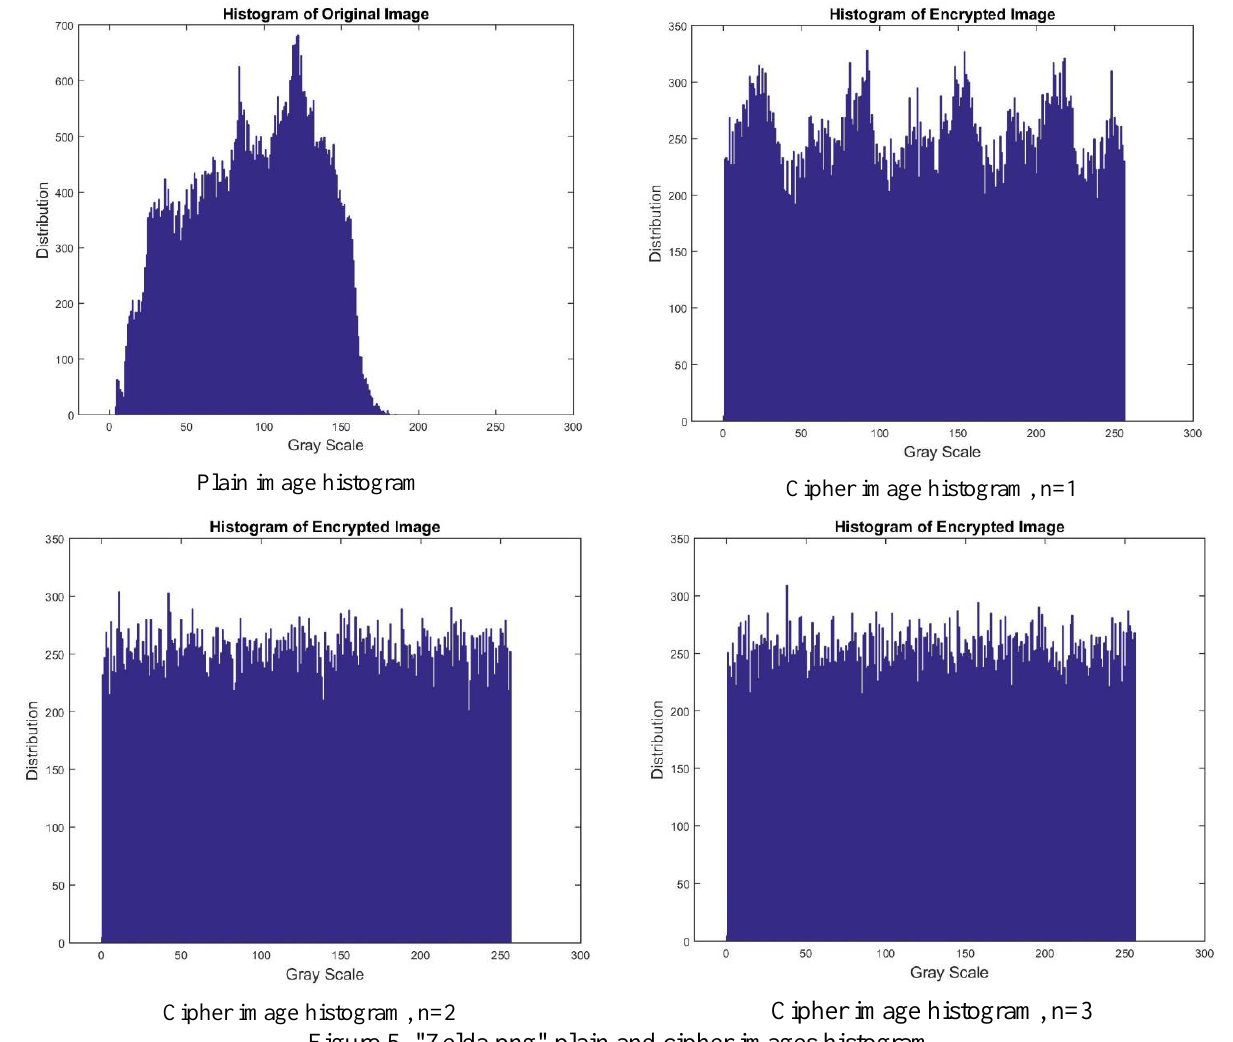
Figure 5. "Zelda.png" plain and cipher images histogram